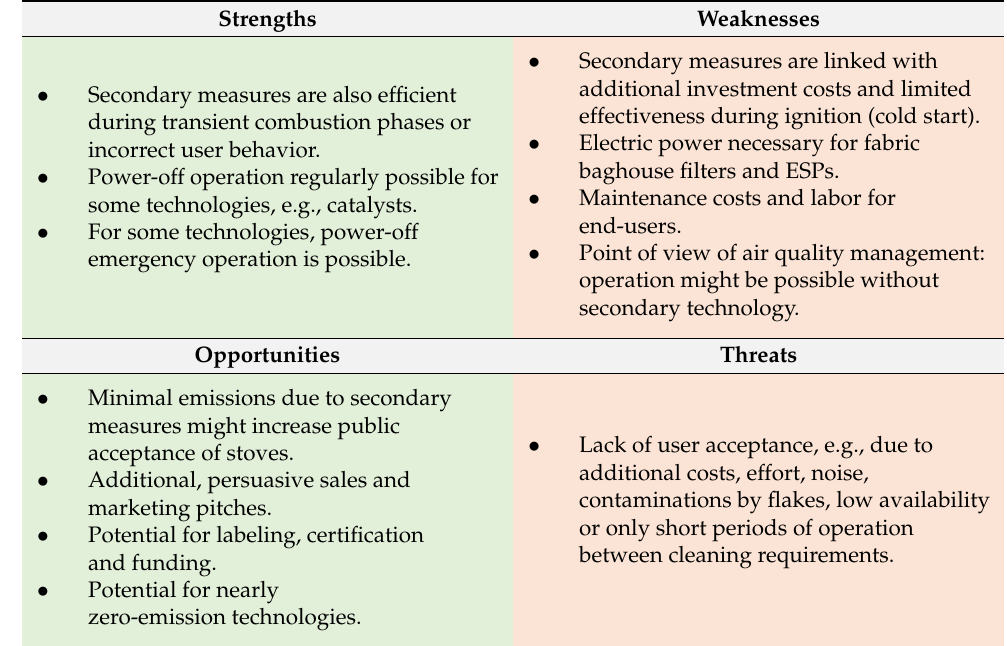
Table 8. SWOT analysis of secondary measures: packing technology (oxidizing reactors), catalysts, fabric baghouse filters, electrostatic precipitators